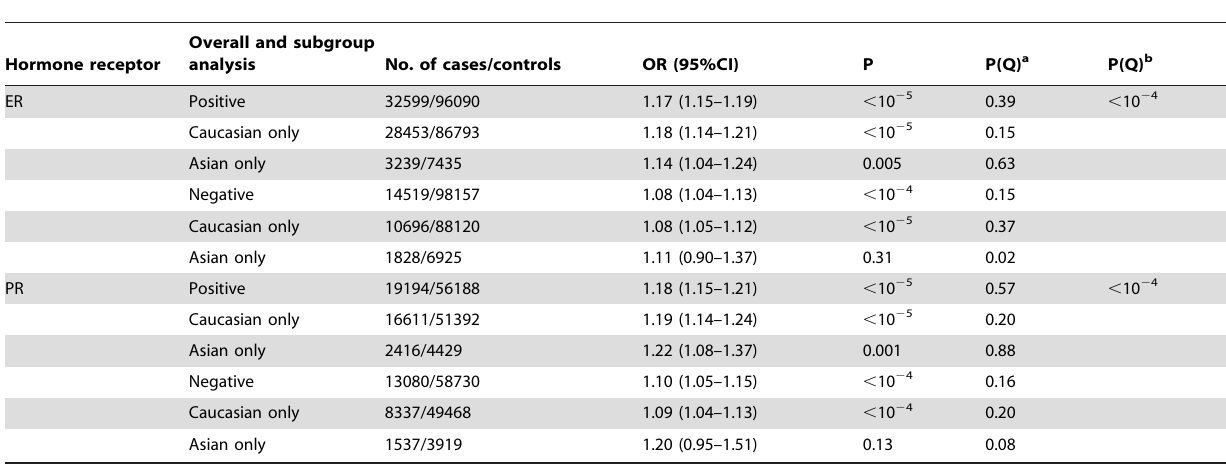
Table 3. Per-allele OR for rs13387042-A variant and BC risk stratified by hormone receptor status.